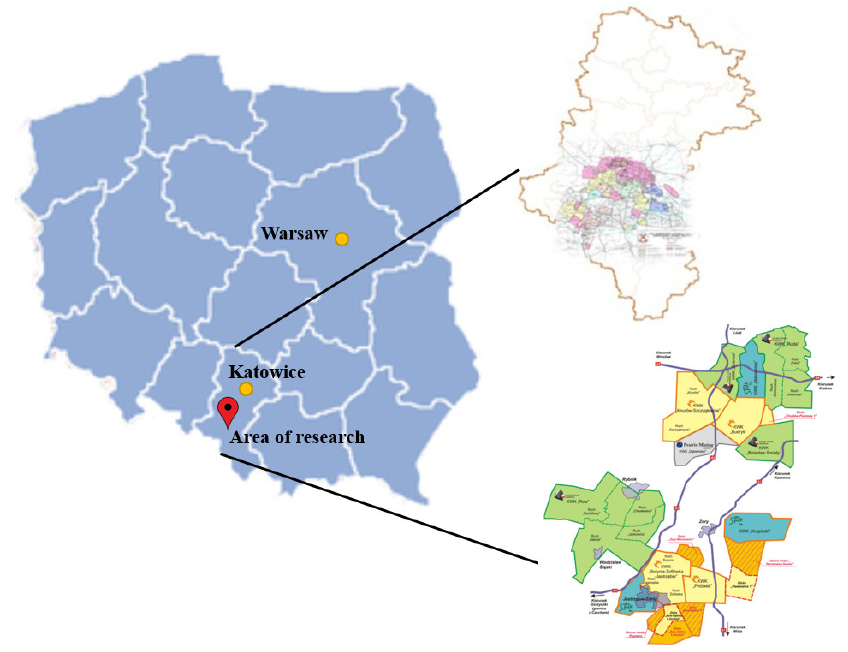
Figure 4. Location of the region where the tests were conducted modified from [42].